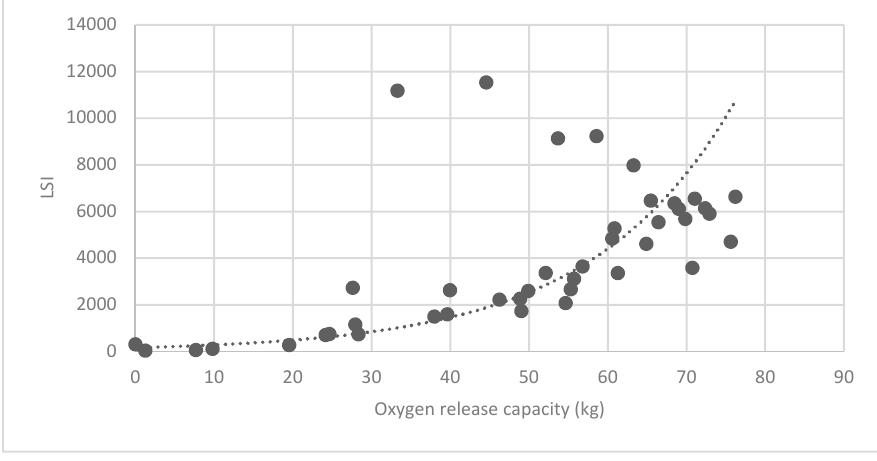
Figure 26. Association between brush LSI and oxygen release capacity.